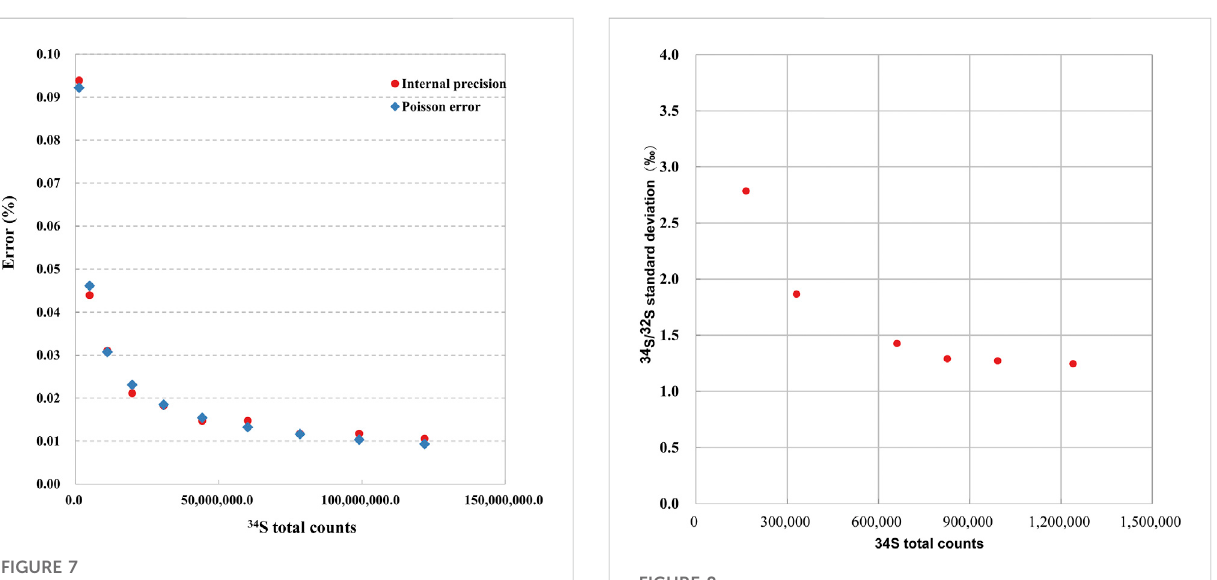
FIGURE 8 The relationship between the external reproducibility of 34 S/ 32 S and the signal statics of 34 S total